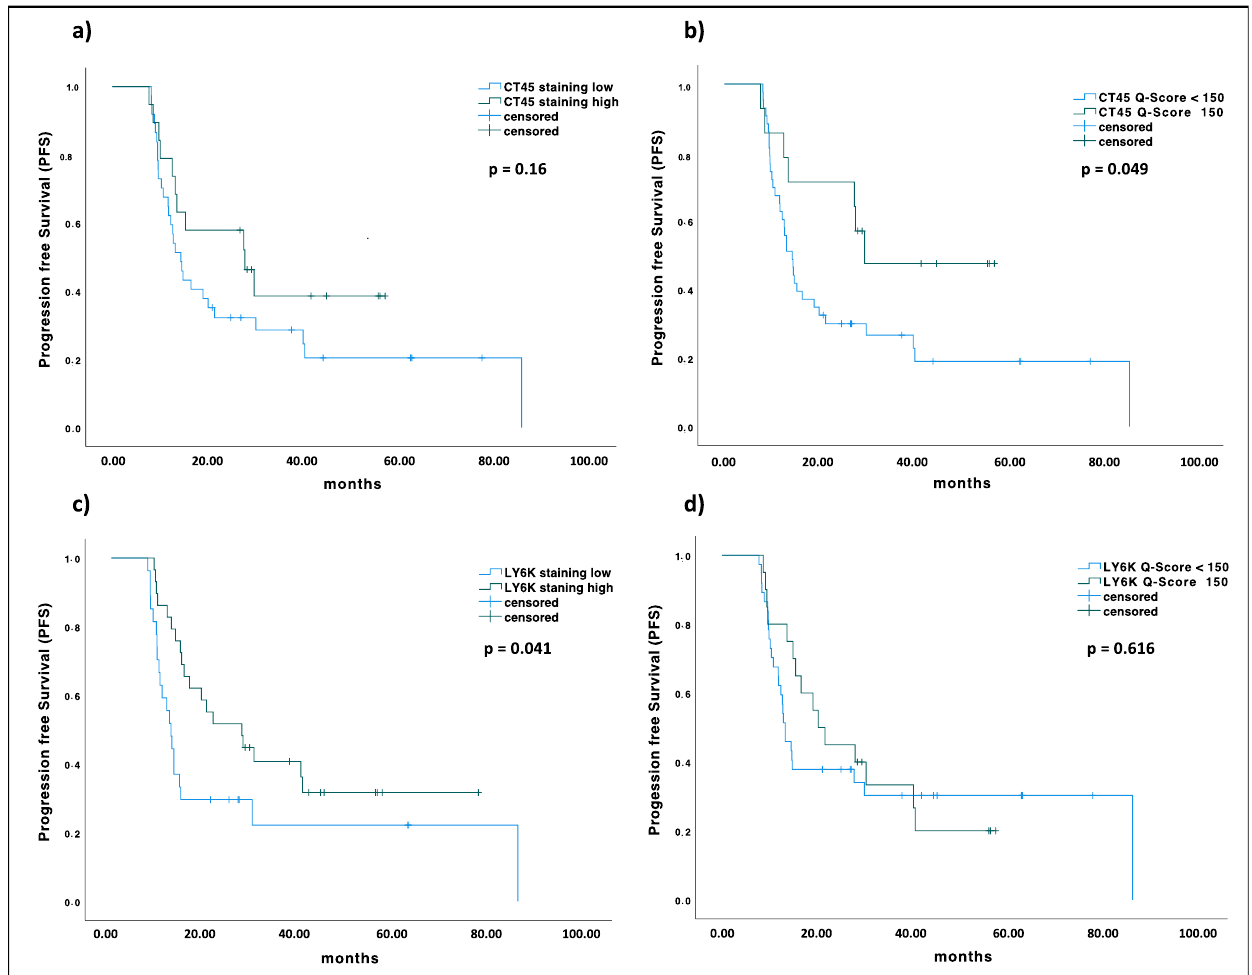
Figure 4. ( a ) Difference in Progression free survival in relation to staining intensity of CT45: blue